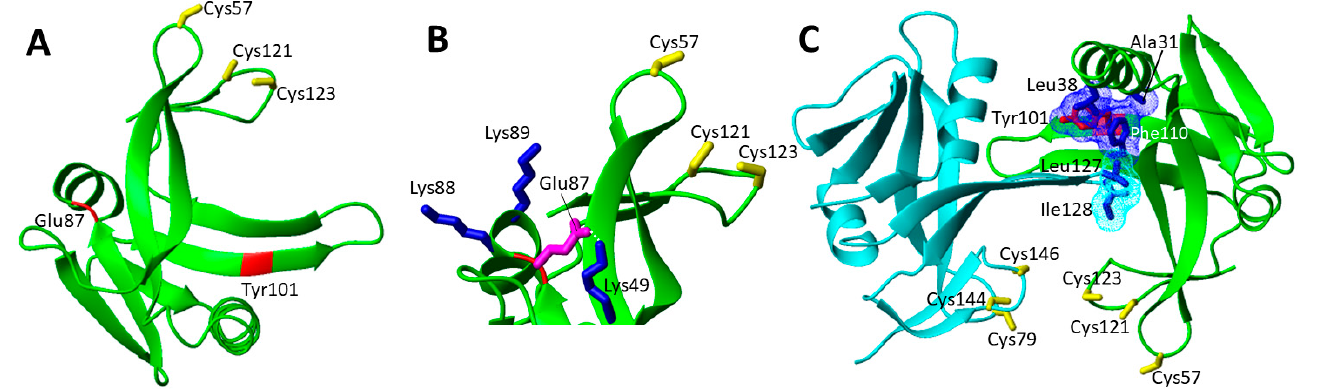
Figure 8. Pathogenic missense mutations mapped on the structural models of human ISCA1 and ISCA1-ISCA2 complex. ( A ) The backbone of the residues involved in pathogenic missense mutations of ISCA1 is colored in red on the structural model of monomeric apo ISCA1 obtained by AlphaFold2, and the sidechains of the three conserved cluster coordinating Cys residues are shown in yellow. ( B ) The hydrogen bond formed between the side-chains of Glu87 (in magenta) and Lys49 (in blue) is shown as a white dotted line. The sidechains of the positively charged Lys88 and Lys89 residues spatially close to Glu87 are also shown. ( C ) The sidechain of Tyr101 is shown in red on the hetero-dimeric apo ISCA1 (green)-ISCA2 (cyan) complex. The interacting hydrophobic patches formed by the sidechains of Tyr101 (in red), Phe110, Leu38 and Ala31 (all in blue) on ISCA1 protomer and by the sidechains of Leu127 and Ile138 (both in blue) on ISCA2 protomer are shown as Van der Waals surfaces in blue and cyan, respectively.